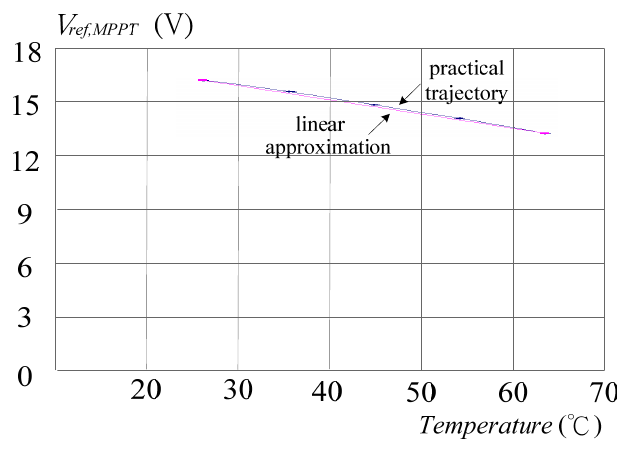
Figure 7. The trajectory of V